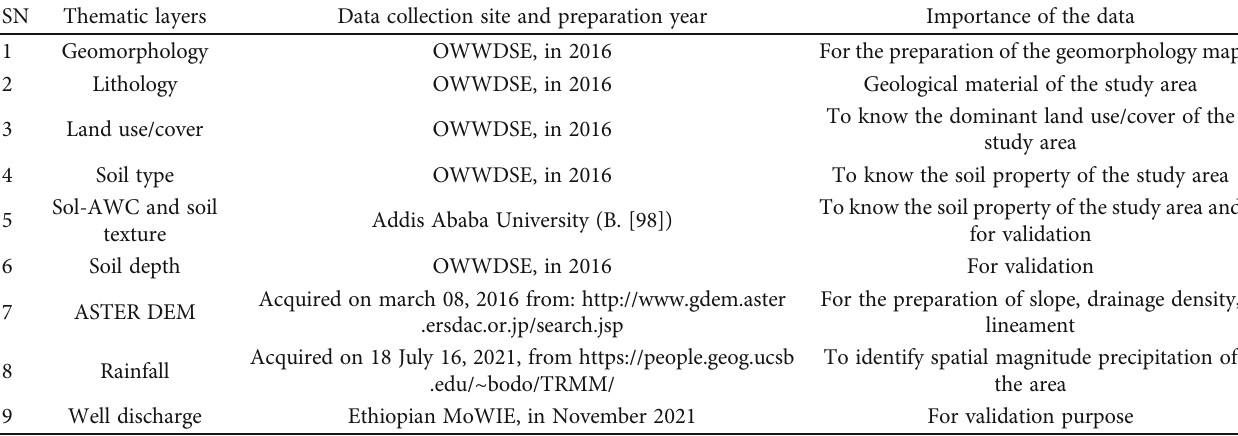
Table 1: The data type, source and importance of thematic